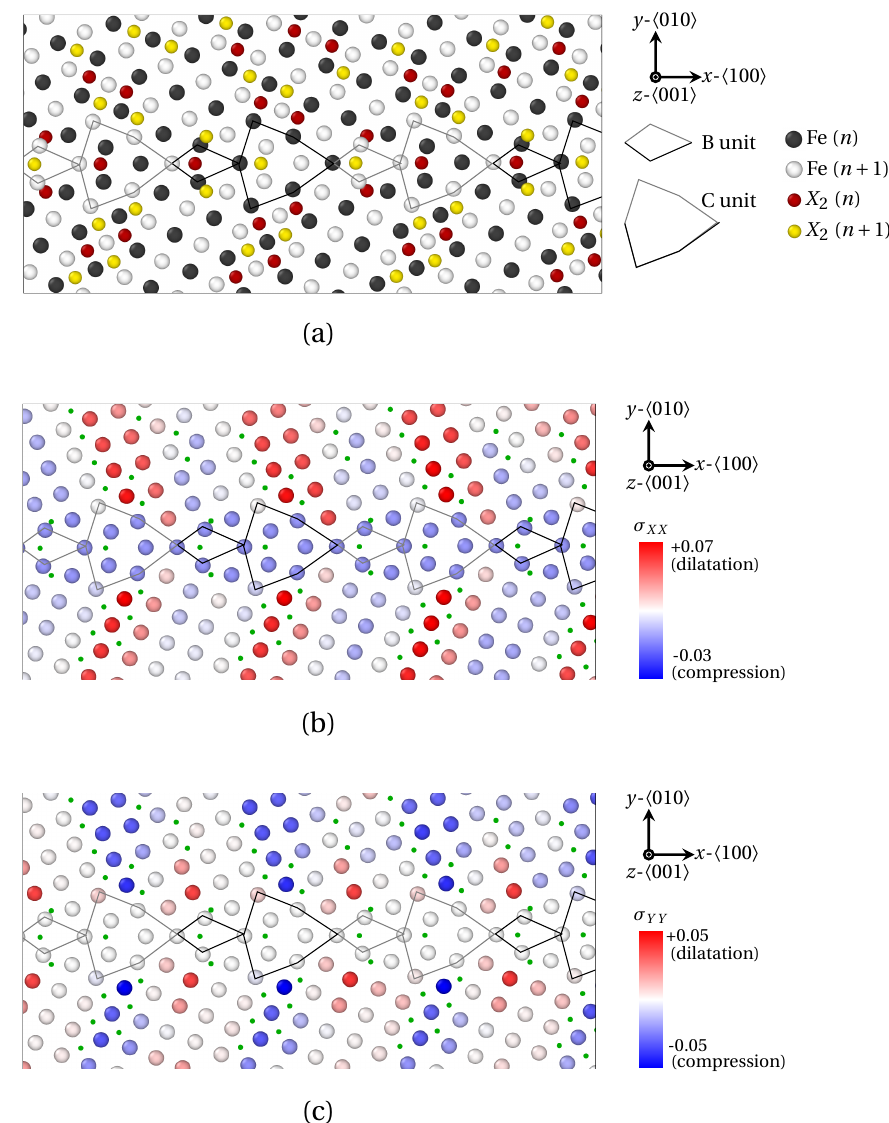
Figure 10. Segregation of X 2 atoms at Σ 29 ( 730 ) ( θ = 46.40 ◦ ) as provided by QA simulations ( t = 400). ( a ) Atoms positions. ( b ) Strain field of Fe atoms in the (cid:104) 100 (cid:105) direction. ( c ) Strain field of Fe atoms in the (cid:104) 010 (cid:105) direction. X 2 atoms are spotted by green dots. B and C structural units are materialized by black ( n plane) and gray ( n + 1 plane)